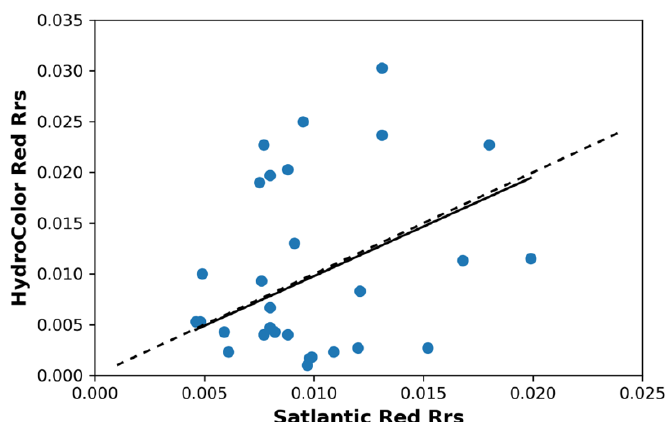
Figure 13. Relationship between the Satlantic and HC-derived Rrs in the Red channel. The solid line represents the regression through the data, and the dashed line represents the 1:1 relationship.